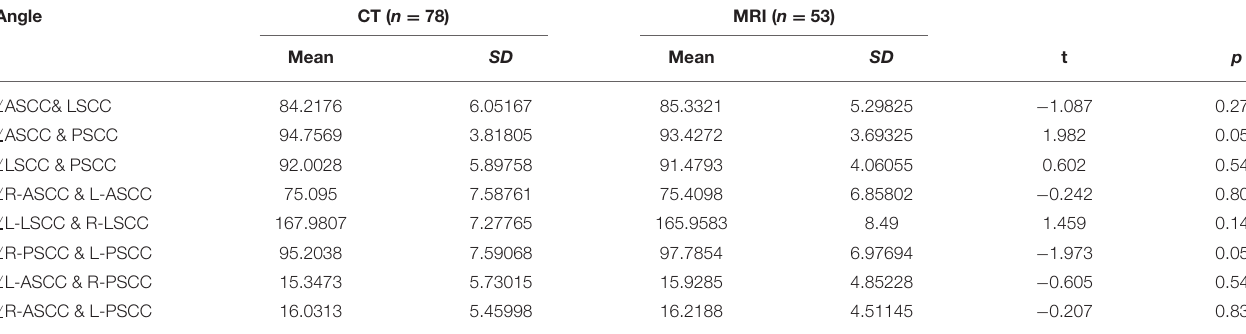
TABLE 1 | Angles (degrees) between the planes of the semicircular canals, measured using CT and MRI. Angle CT ( n = 78) MRI ( n = 53) Mean SD Mean